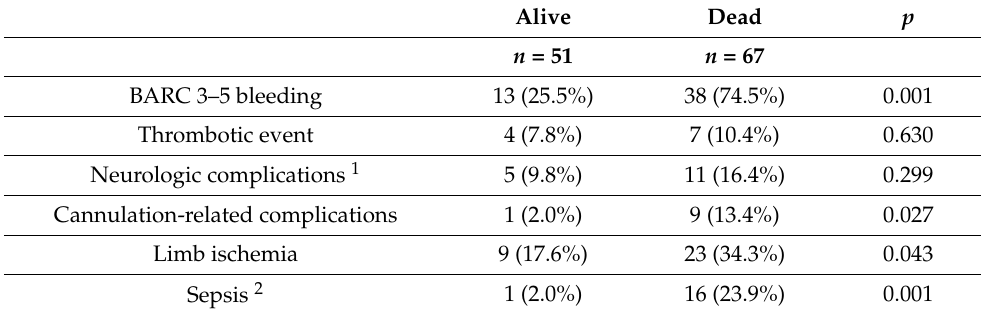
Table A2. Comparison of major complications in survivors at 30-days and dead.